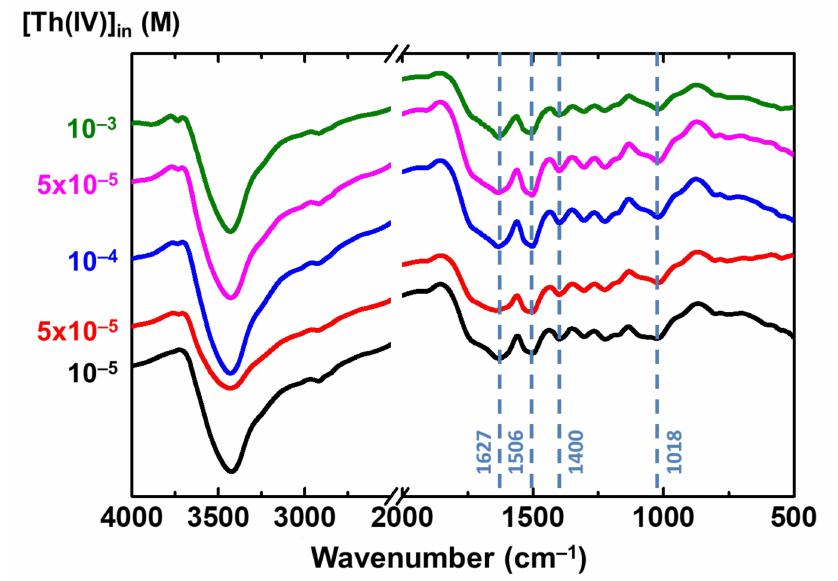
Figure 7. FTIR spectra of dried X-alginate beads after sorption of different amounts of Th(IV) from